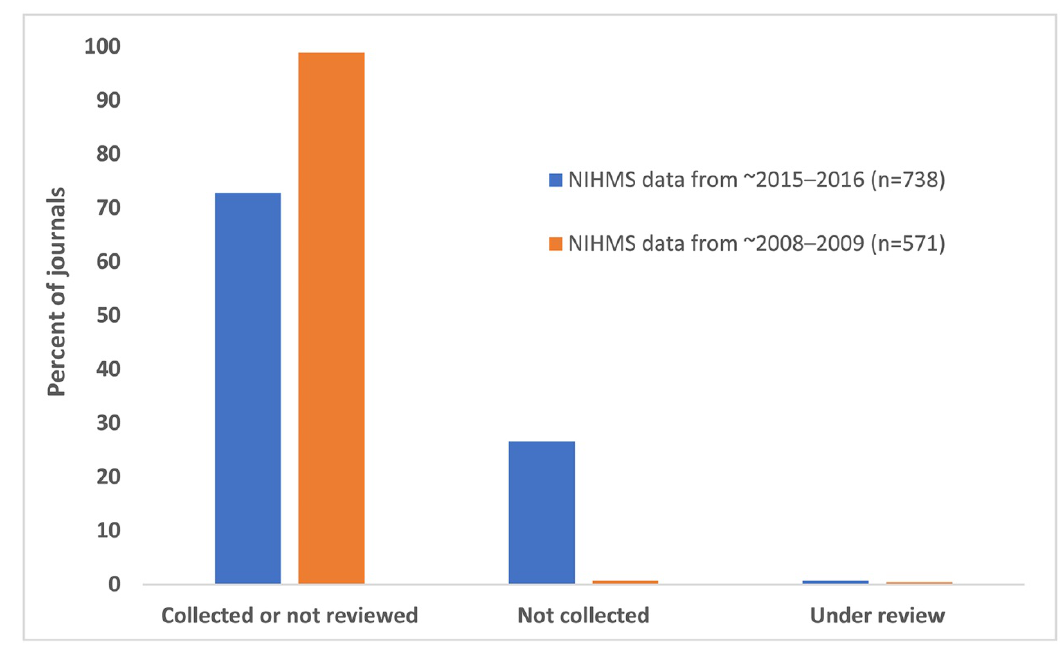
Figure 4 Percentage of publications in the NIHMS datasets that were produced by publishers NLM does not collect